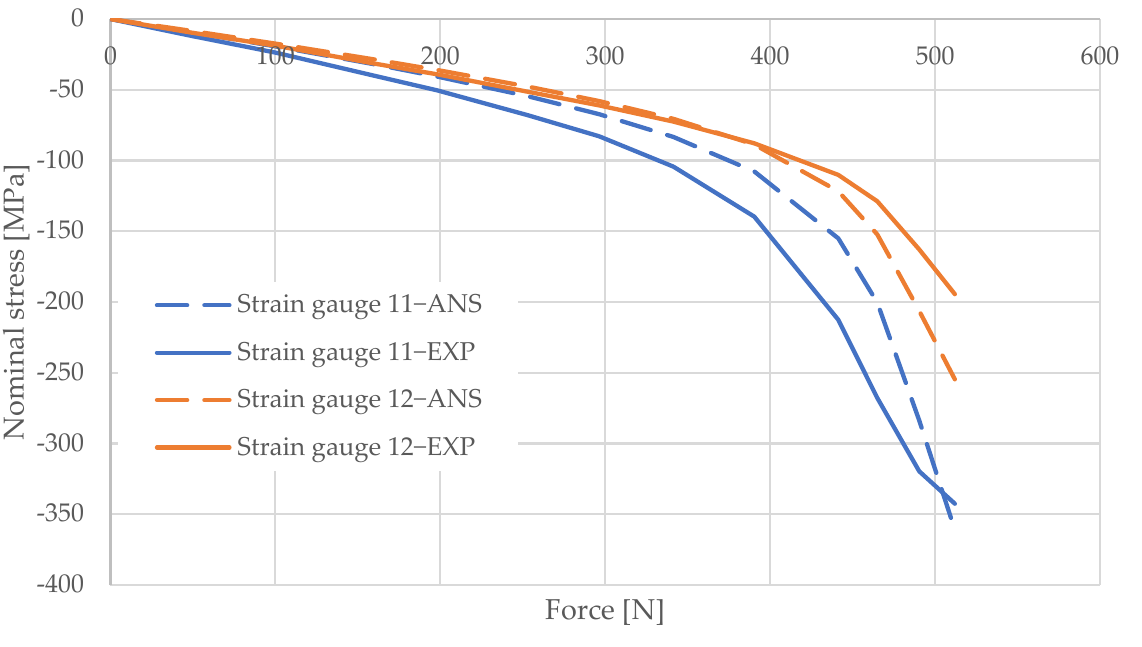
Figure 13. Pole 5/3 — values of normal stress readings from strain gauges no. 11 and 12. Figure 13. Pole 5/3—values of normal stress readings from strain gauges no. 11 and 12.